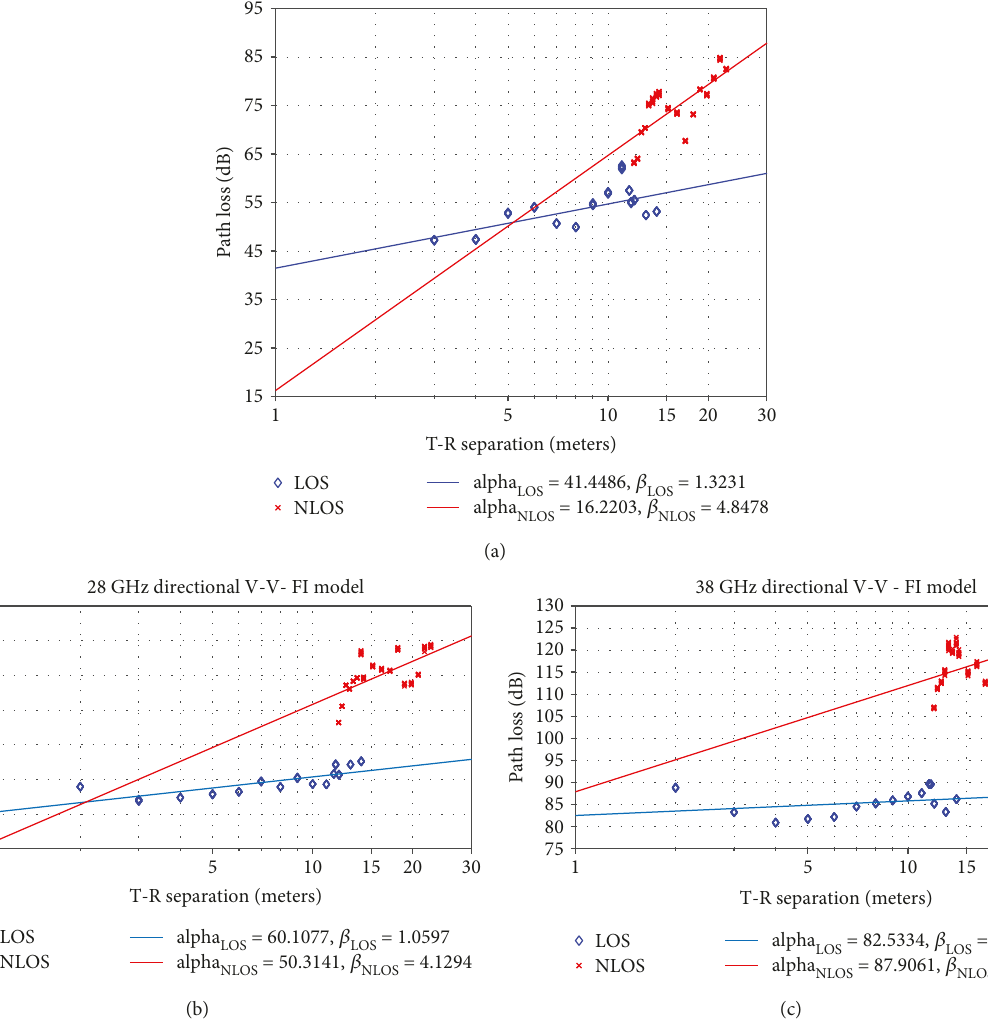
Figure 5: Directional V-V FI path loss model for LOS and NLOS (a) 4.5GHz, (b) 28 GHz, and (c) 38 GHz.